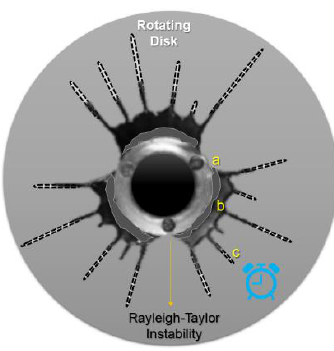
Figure 7. Polymeric finger prints from nozzle-less RJS increasing with processing time (modified with permission from [37], Copyright 2014 Elsevier).